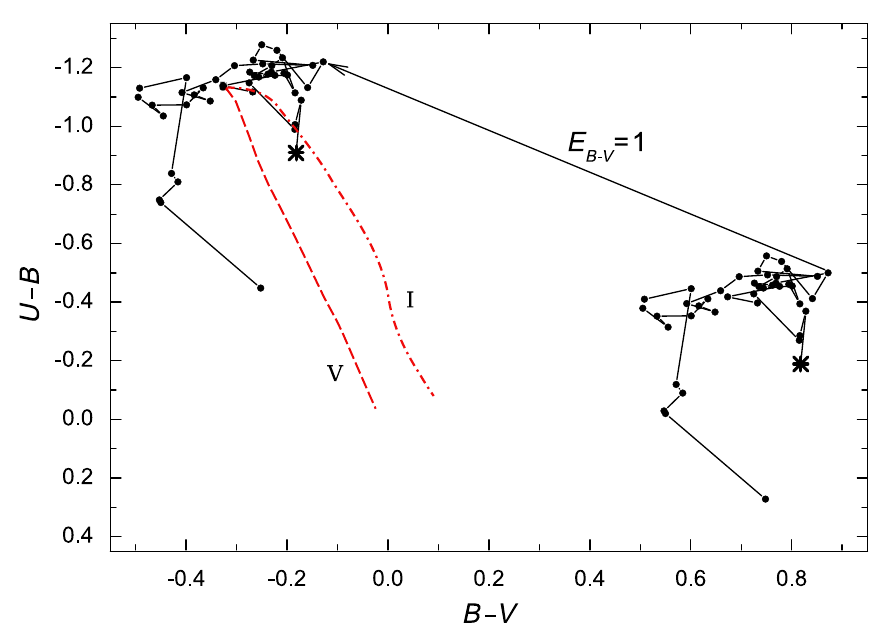
Fig. 2. The observed U (cid:0) B vs. B (cid:0) V diagram and the diagram dereddened with E B (cid:0) V = 1 for V2659 Cyg. The (cid:12)rst observation is marked with an asterisk. We also plot parts of the main sequence (the dashed curve labeled \V") and the supergiant sequence (the dash-dotted curve labeled